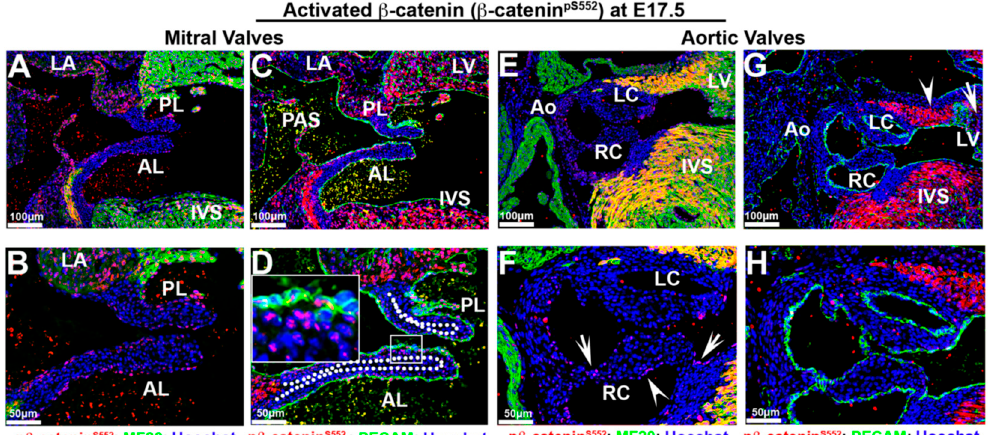
Figure 6. Activated β -catenin is downregulated in valvular tissues at E17.5 with non-uniform expression in myocardium. ( A – D ) Activated β -catenin was primarily observed in a subset of endocardial and subendocardial mesenchyme (boxed region in ( D )). Most interstitial cells exhibited either undetectable or low levels of nuclear β -catenin expression. Regions outside of the mitral or aortic valves showed prominent nuclear β -catenin staining, including the primary atrial septum (PAS), the myocardial rim lining the mitral–aortic continuity, the left ventricular wall, the interventricular septum (IVS: interventricular septum), but the myocardium of the left atrium had much lower staining intensity than the adjacent left ventricular wall. ( E – F ). Activated β -catenin was only expressed in a few cells within the hinge regions connecting the aortic cusps to the aortic wall (( F )—arrows). Additionally, a few cells along one side of the right coronary cusp were positive for nuclear β -catenin expression (( F )—arrowheads) ( G , H ). Within the proximal/anterior heart regions, activated β -catenin expression was observed within the myocardial reflections adjacent to the aortic wall (( G )—arrowhead), whereas it was absent at basal myocardium (( G )—arrow). LC = left coronary cusp, RC = right coronary cusp, LV = left ventricle.